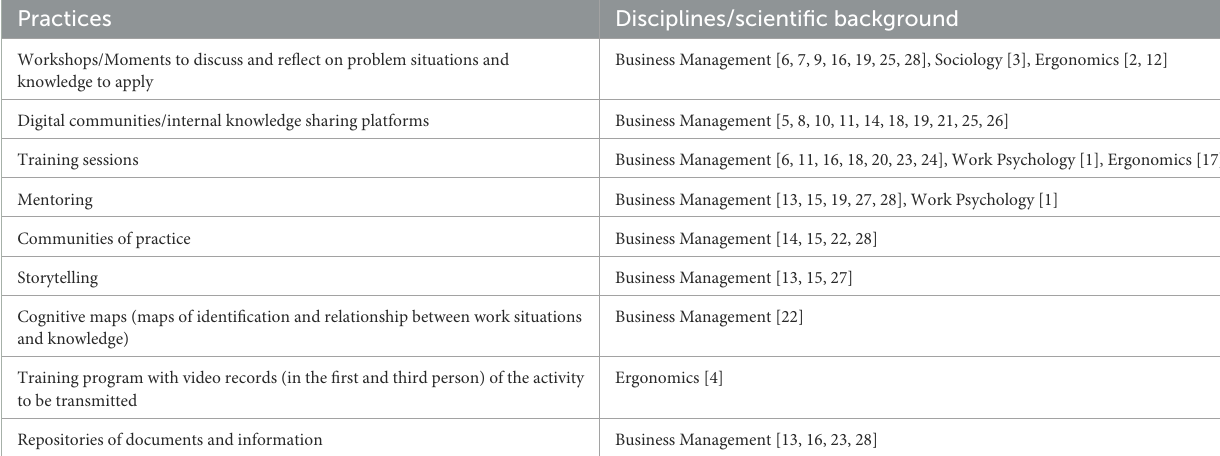
TABLE 3 Types of practices for management or transmission of knowledge identified in the articles, and their scientific background.